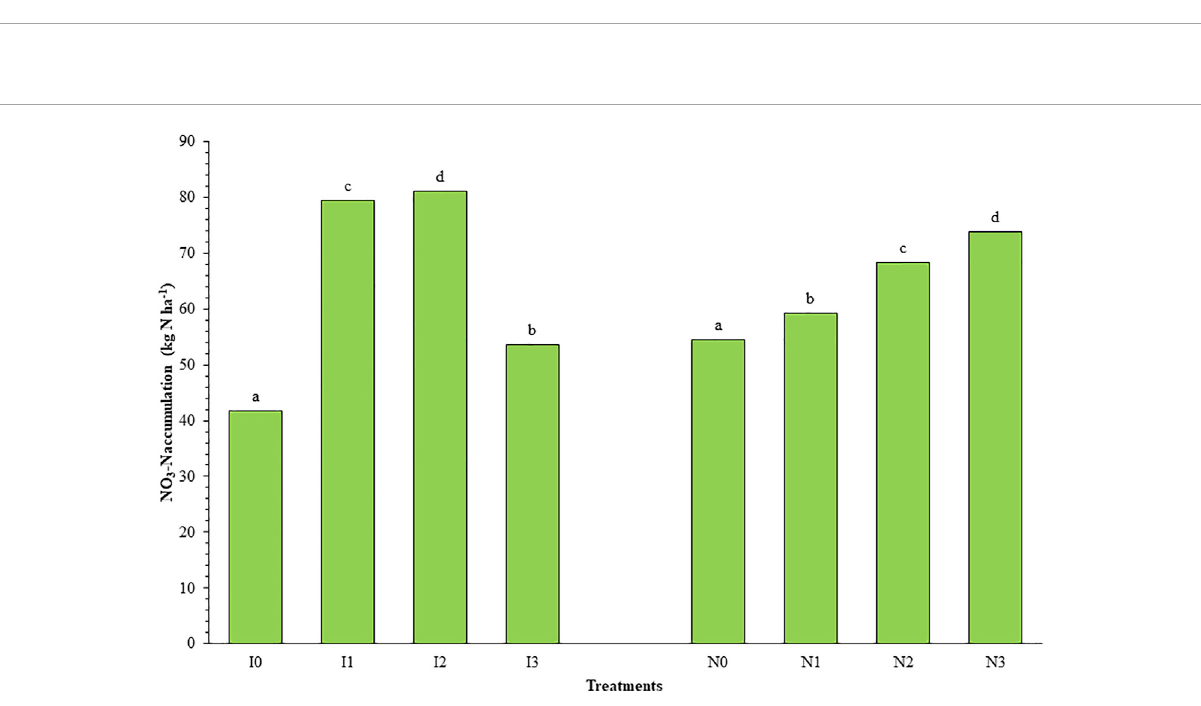
Frontiers in Environmental